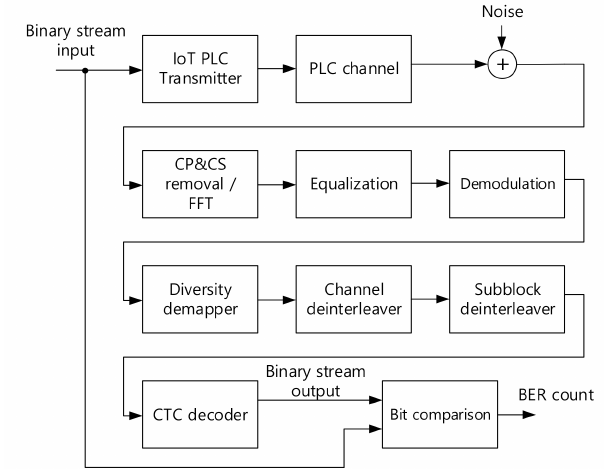
Figure 11. Simulation block diagram for BER